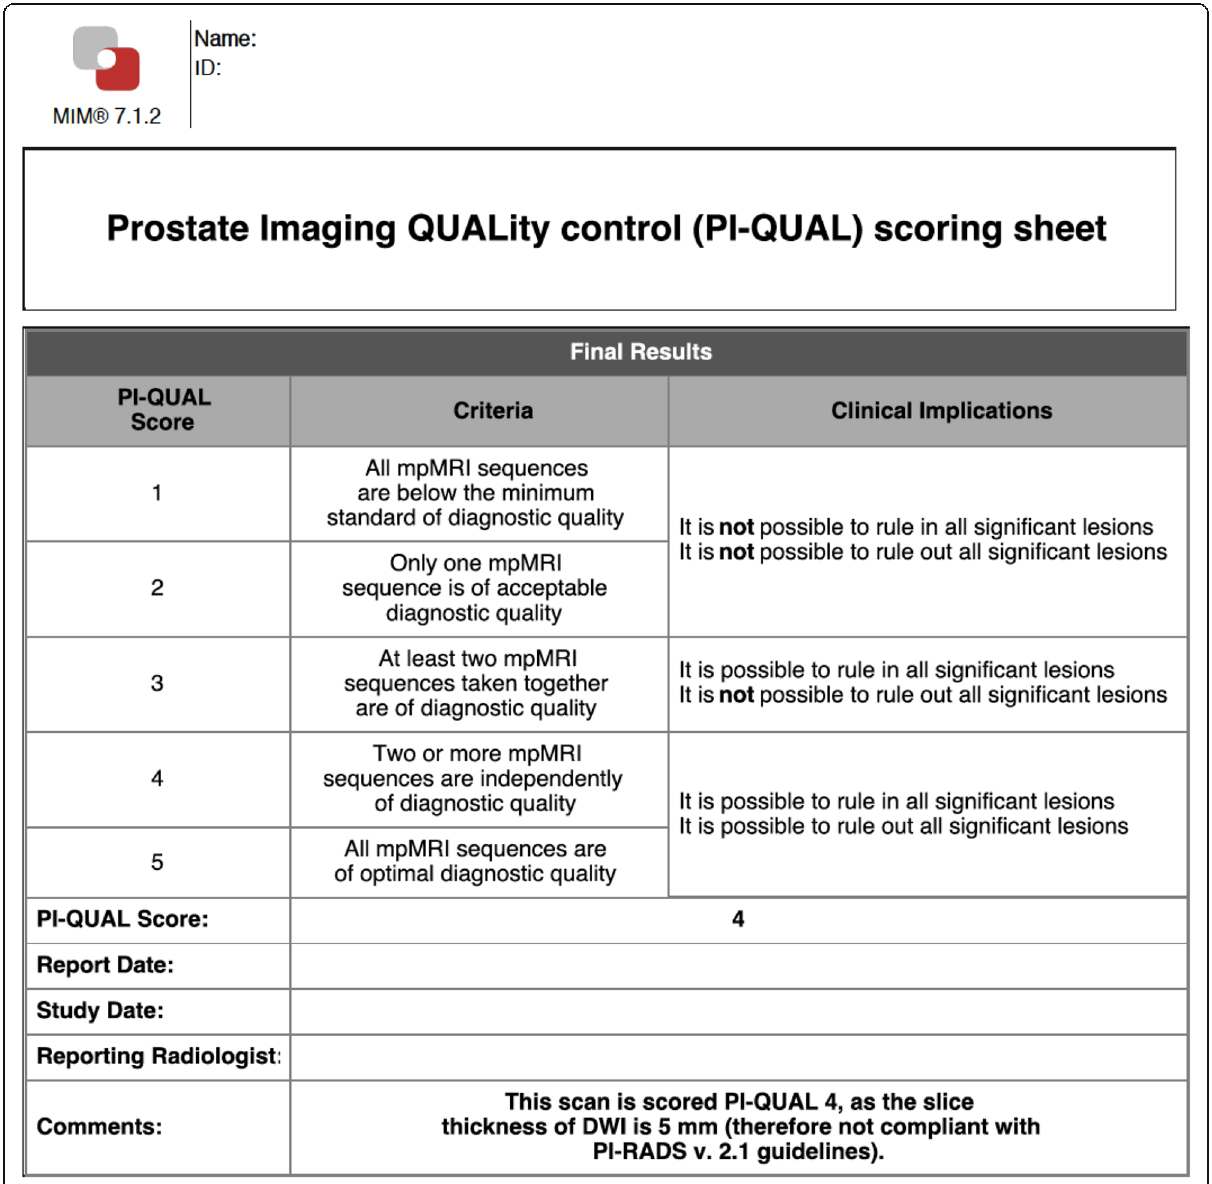
Fig. 2 Structured report obtained using the dedicated PI-QUAL software